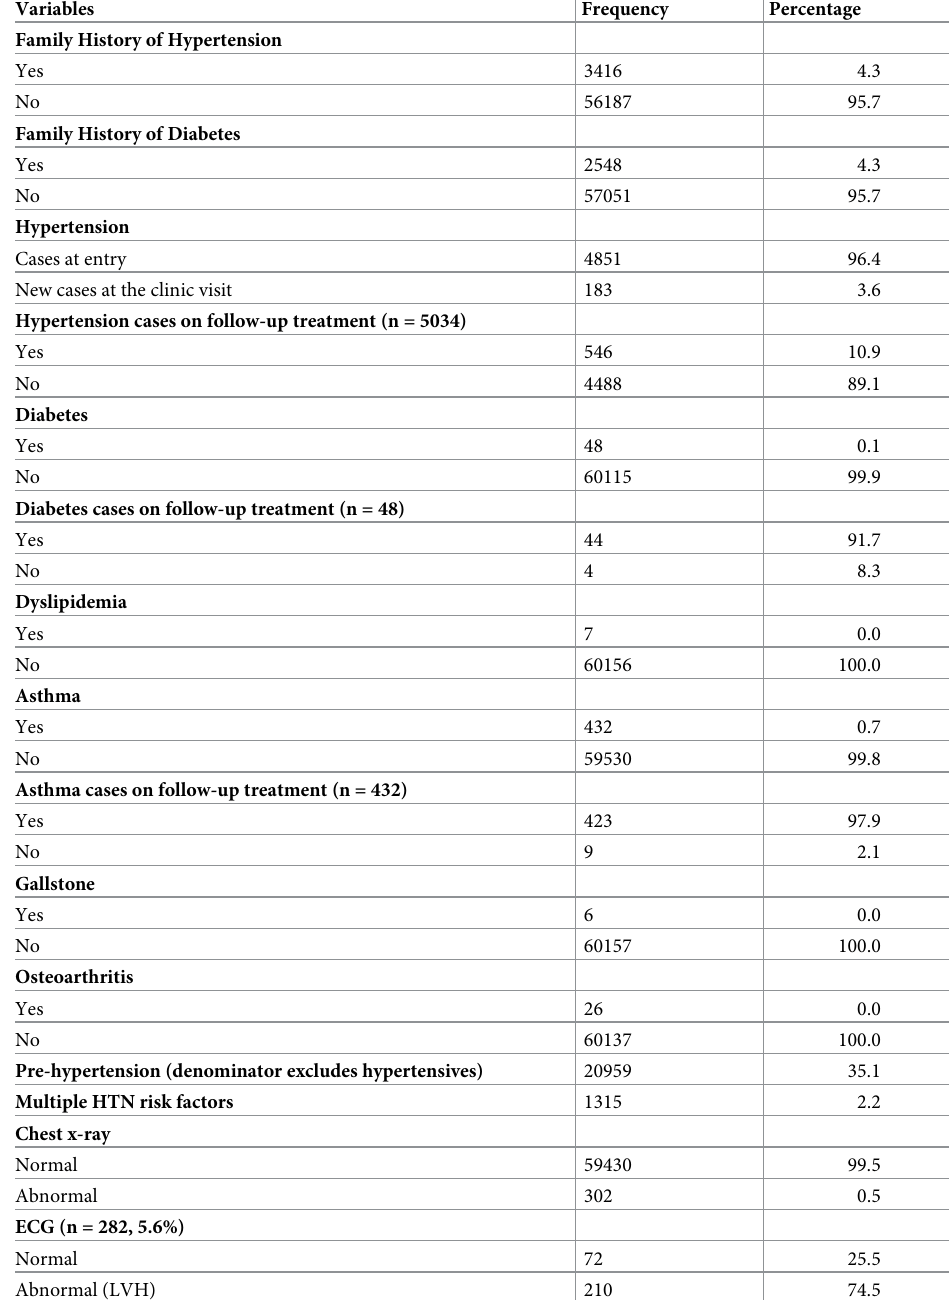
Table 3. Medical history and obesity-related disease profile of students attending the University of Ibadan health centre from 2009–2018.